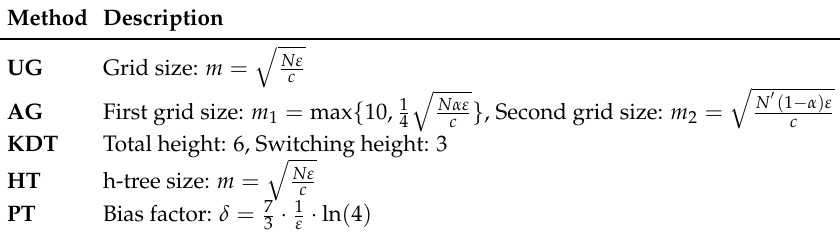
Table 2. Parameter configurations for each method.